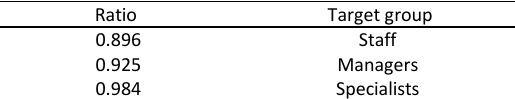
Table 5: Reliability of the questionnaires